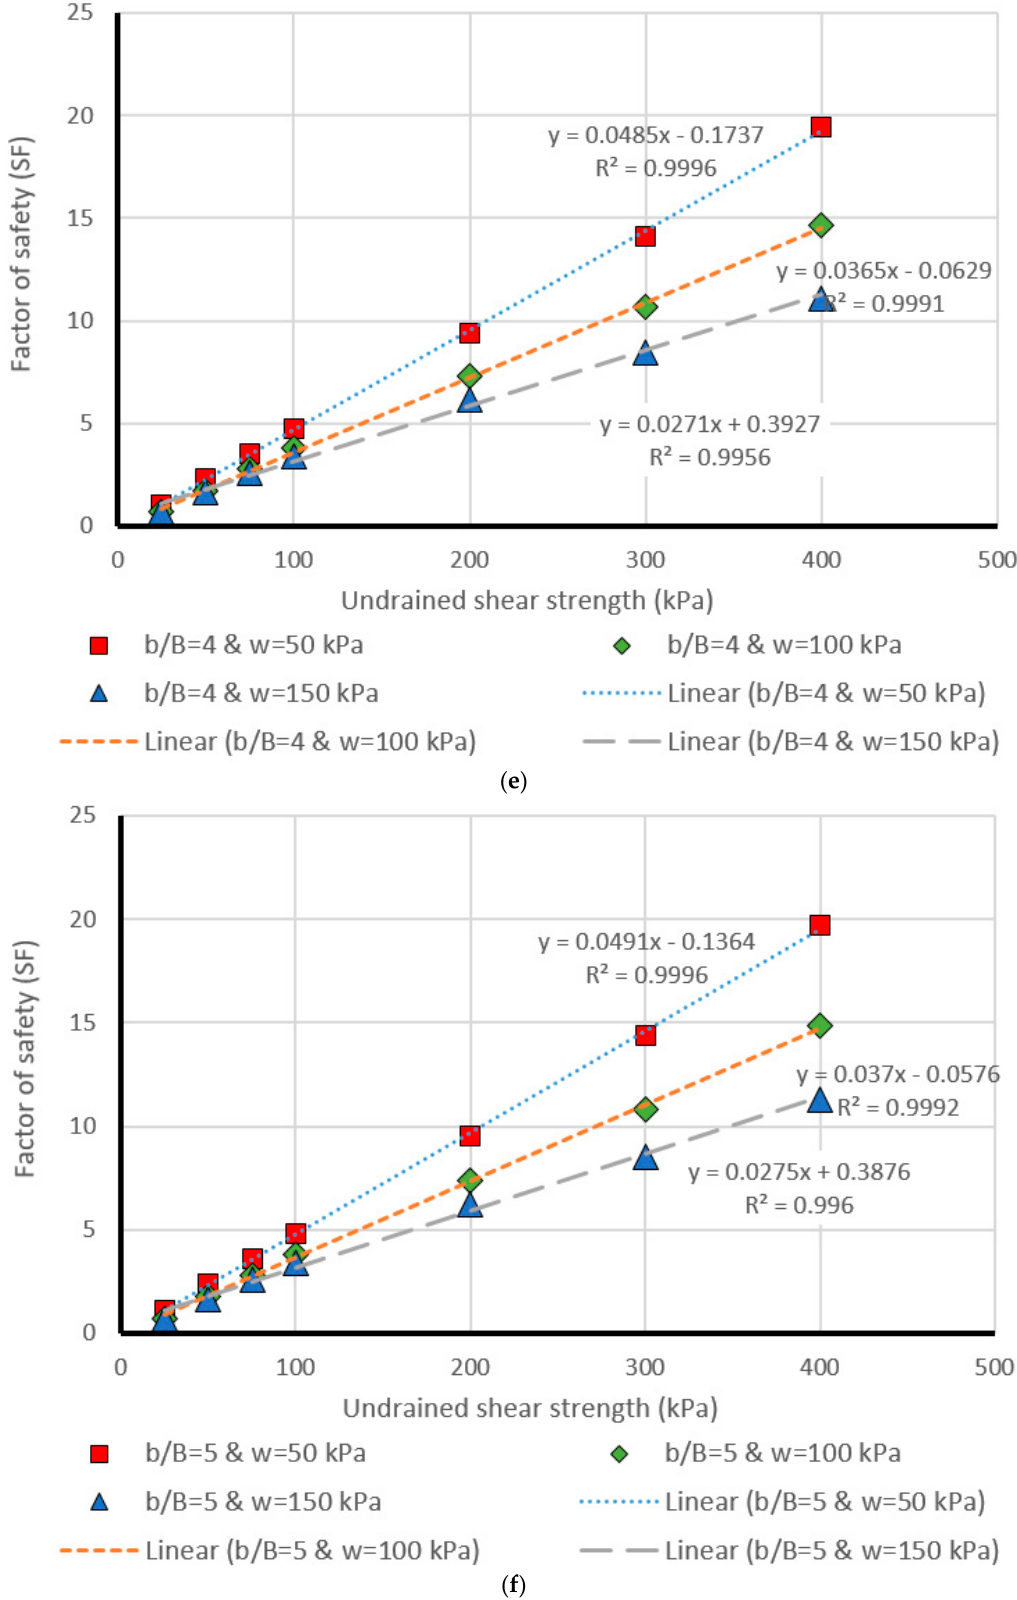
Figure 11. Comparison of the MLP estimation and real values of FS for the β = 60°, ( a ) b/B = 0, ( b ) b/B = 1, ( c ) b/B = 2, ( d ) b/B = 3, ( e ) b/B = 4, ( f ) b/B = 5.